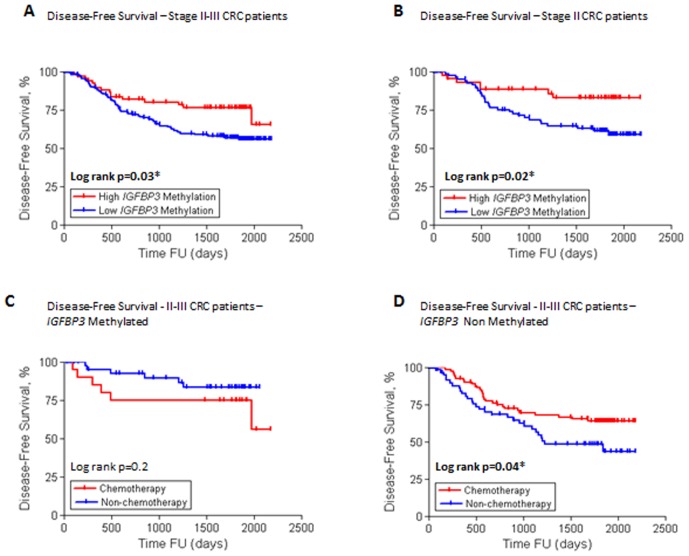
Relationship between igfbp3 methylation and prognostic and predictive response in stage ii and iii crc patients.(a) Disease-free survival of patients with stage ii and iii crc, according to igfbp3 methylation status (high methylation, n = 73, (30.3%) low methylation, n = 168, (69.7%). (b) Disease-free survival of patients with stage ii disease, according to igfbp3 methylation (high methylation, n = 45, (32.4%); low methylation, n = 94, (67.6%). (c) Disease-free survival of patients with stage ii and iii disease, in high igfbp3 methylation tumors based on adjuvant chemotherapy (chemotherapy, n = 20, (22.5%); no chemotherapy, n = 69, (77.5%). (d) Disease-free survival of patients with stage ii and iii disease, in low igfbp3 methylation tumors according to adjuvant chemotherapy (Chemotherapyc n = 83, (52.7%); NO Chemotherapy, n = 74, (47.2%).